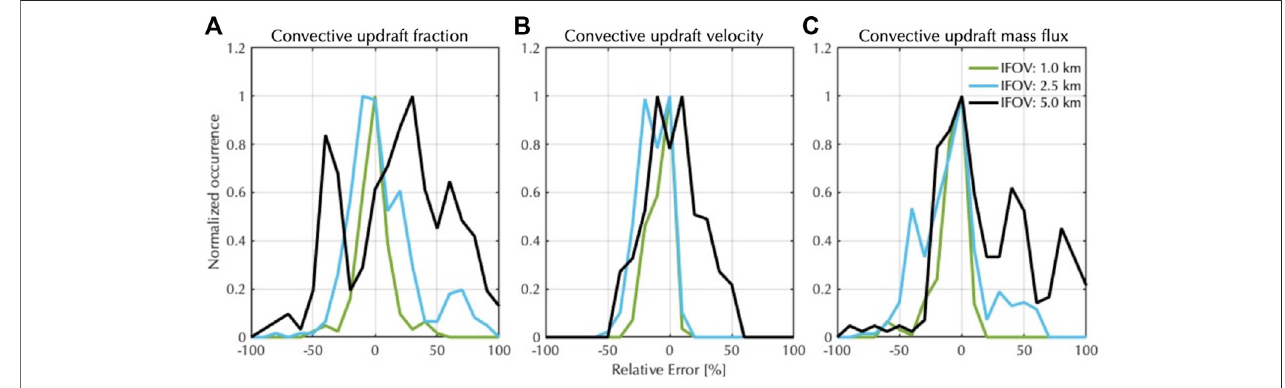
· 100% ) in the (A) convective updraft fraction, (B) mean convective updraft velocity, and (C) FIGURE 5 | Normalized distribution of the relative error ( model − radar model convectiveupdraftmass fl ux.Resultsareshownforthreedifferentinstantaneousradar fi eldofviewsclosetothatofradar1(1.0 km;green),radar5(2.5 km;cyan),radar 4 (5.0 km;